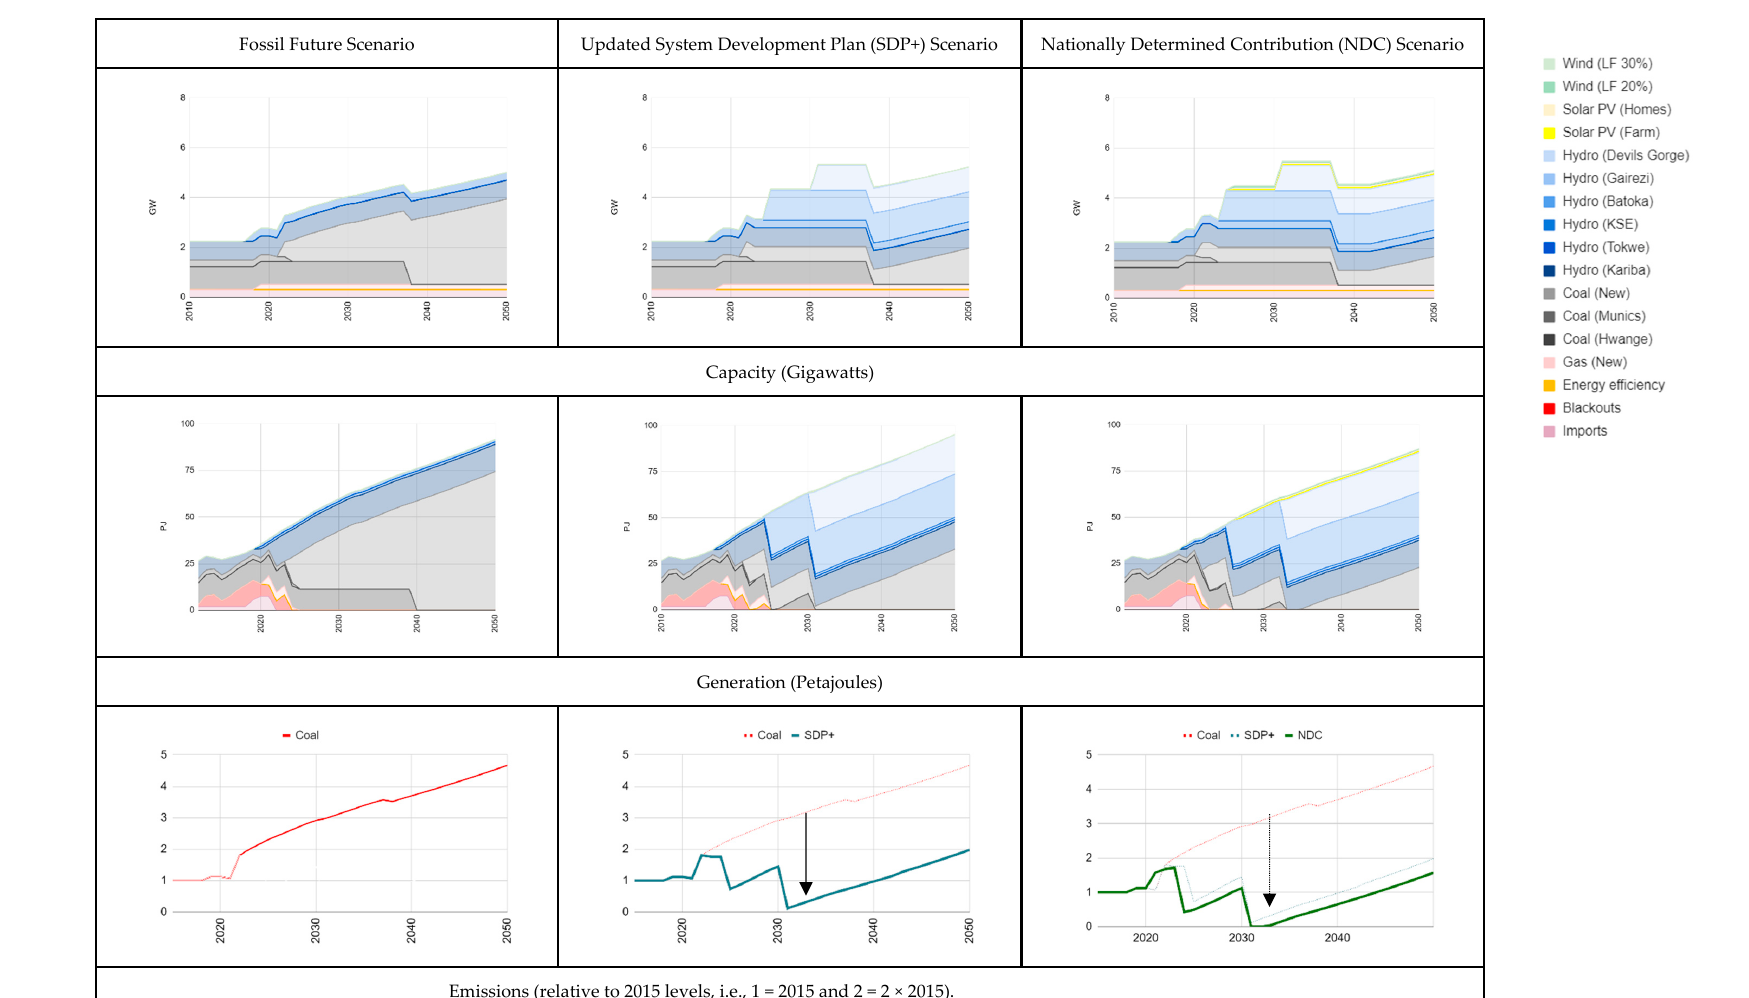
Figure 2. Study Results—Zimbabwe’s energy future without the threat of Climate Change. (In this simulation, there are zero emissions for some years just after the full exploitation of the Devils Gorge hydro station. Recall that this is for the electricity sector only, and, note, that in those years no fossil fuel-based power is being generated at all. Additionally, note that in the Fossil Future scenario, emissions will increase 5-fold between 2015 and